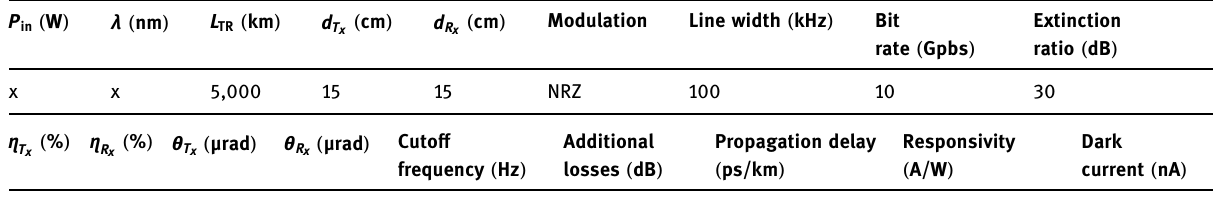
Table 1: Parameters used in OptiSystem for the simulation of Figure 3